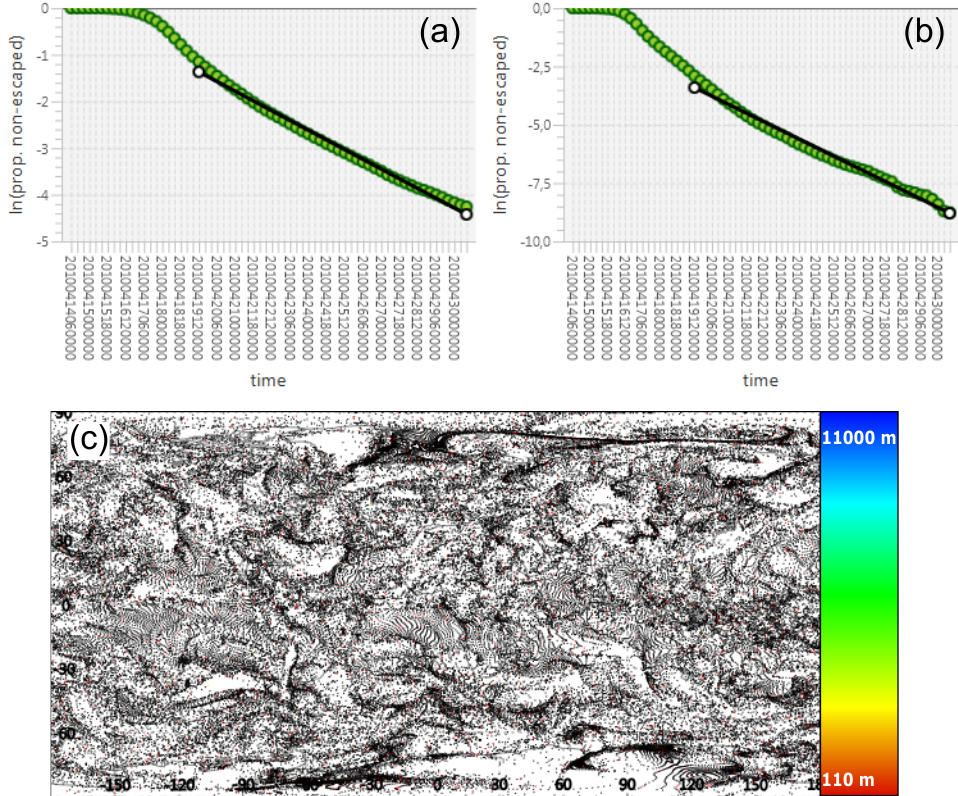
Figure 3. ( a , b ) The time-dependence of the logarithm of the ratio of non-escaped particles. The simulations are initialized with the simulation parameters on the left of Figure A1 but with an end date of “2010.04.30.12:00:00” and with calculating the ratio of non-escaped particles. The pollutant clouds are initialized as 300 × 300 × 1 particles at 0 ◦ N, 0 ◦ E and at the altitude of 5500 m with an extension of 4 × 10 4 km × 2 × 10 4 km × 0 m (i.e., covering the entire globe uniformly at a single altitude). The particle density is 2000 kgm − 3 and the particle radius is ( a ) 7 µ m and ( b ) 9 µ m, respectively. The black lines indicate linear fits to the logarithm of ratio of non-escaped particles for the time interval from 19 April, 12 UTC to 30 April, 12 UTC. The ( − 1 ) × slopes are ( a ) κ = 0.278 day − 1 and ( b ) κ = 0.489 day − 1 . ( c ) The deposition pattern of the particles in panel ( b ) at 30 April 2010 at 12 UTC. Colorbar indicates the altitude of the particles, black color marks deposited